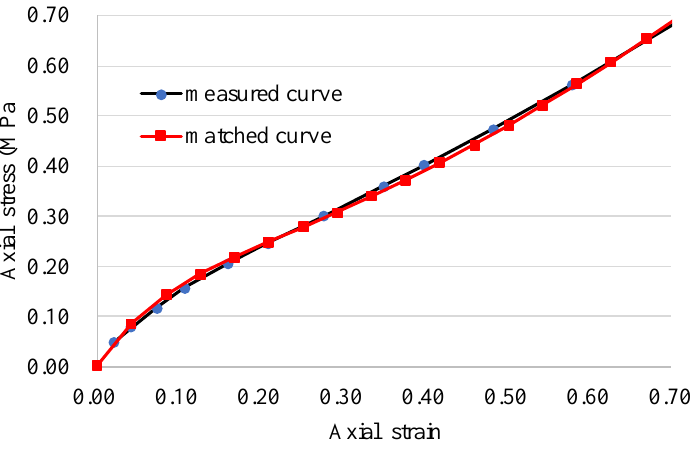
Figure 4. The measured stress–strain curve and fitting result of the silicone rubber strip sample.